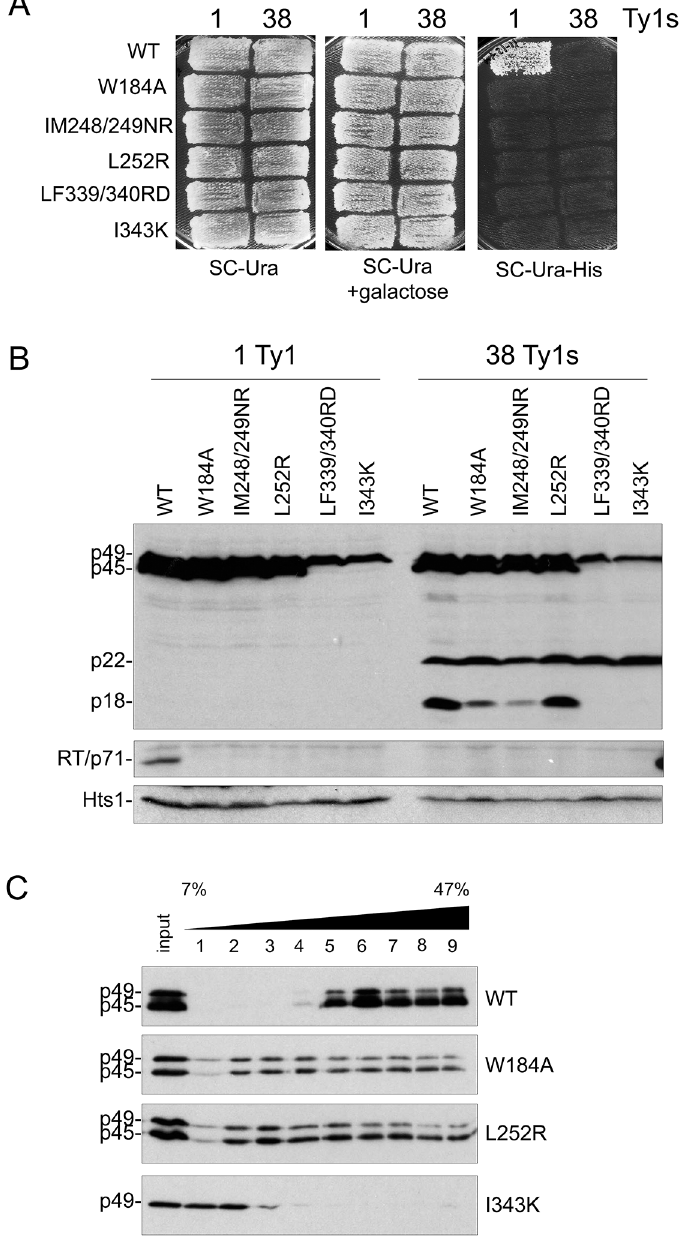
Fig 4. Alterations in Gag helical domains disrupt transposition and Ty1 protein cleavage. S . paradoxus repopulated with 1 (YEM514) or 38 (YEM515) genomic copies of Ty1-H3 and containing wild type or helix mutant pGTy1 his3-AI plasmids were analyzed for Ty1 his3-AI mobility using a qualitative plate assay (A) and for Ty1 protein levels (B). (A) Cells grown on SC-Ura were induced for pGTy1 his3-AI expression and retrotransposition by replica plating to SC-Ura + 2% galactose and incubating at 22°C for 2 days. Cell patches were replicated to SC-Ura-His and grown at 30°C until His + papillae appeared. Each His + colony contains at least one Ty1 HIS3 insertion. (B) Cells were induced in liquid SC-Ura + 2% galactose medium for 24 h and TCA-extracted proteins were immunoblotted with p18, RT, and Hts1 antibodies. (C) Cell extracts from 1 Ty1 copy strain expressing helix mutant pGTy1 his3-AI plasmids were centrifuged through a 7 – 47% continuous sucrose gradient. Equal volumes of each fraction were immunoblotted with TY antibody, which recognizes full length Gag